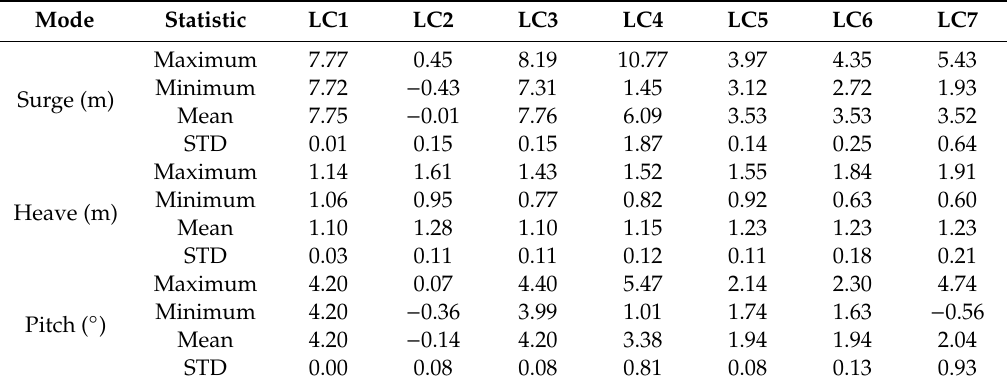
Table 7. Statistical results of the platform motions in di ff erent